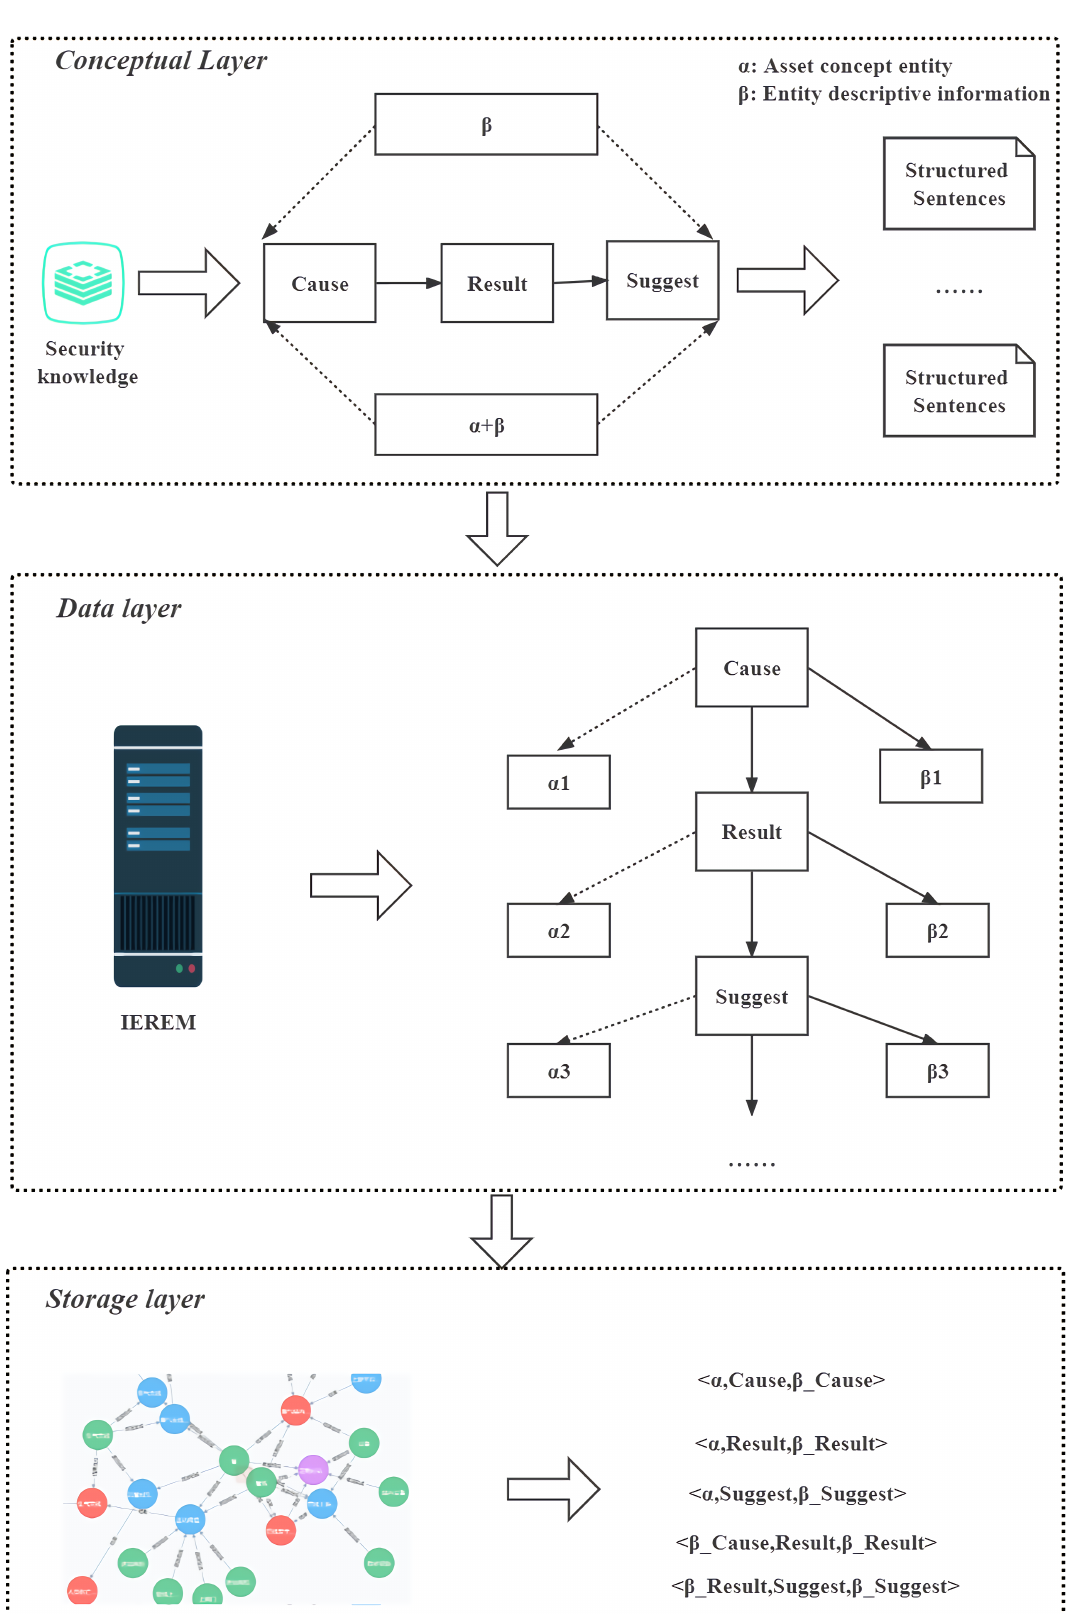
Figure 1. Industrial safety knowledge development